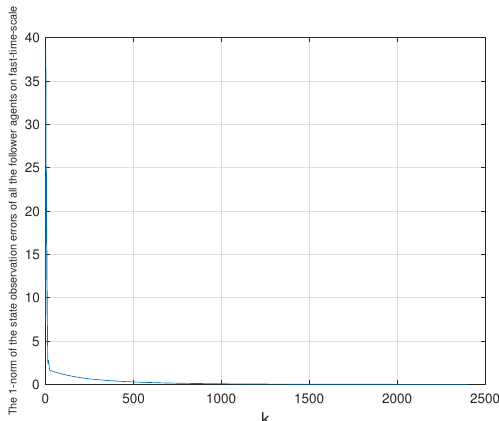
Figure 8. The 1-norm of the state observation errors of all the follower agents on fast-time scale.